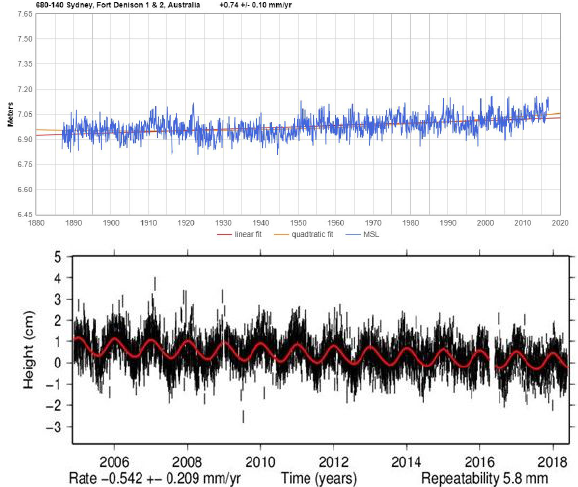
Figure 5: MSL (top) and GPS (bottom) data for Sydney. Images repro- duced and modified after http://www.sealevel.info/ and